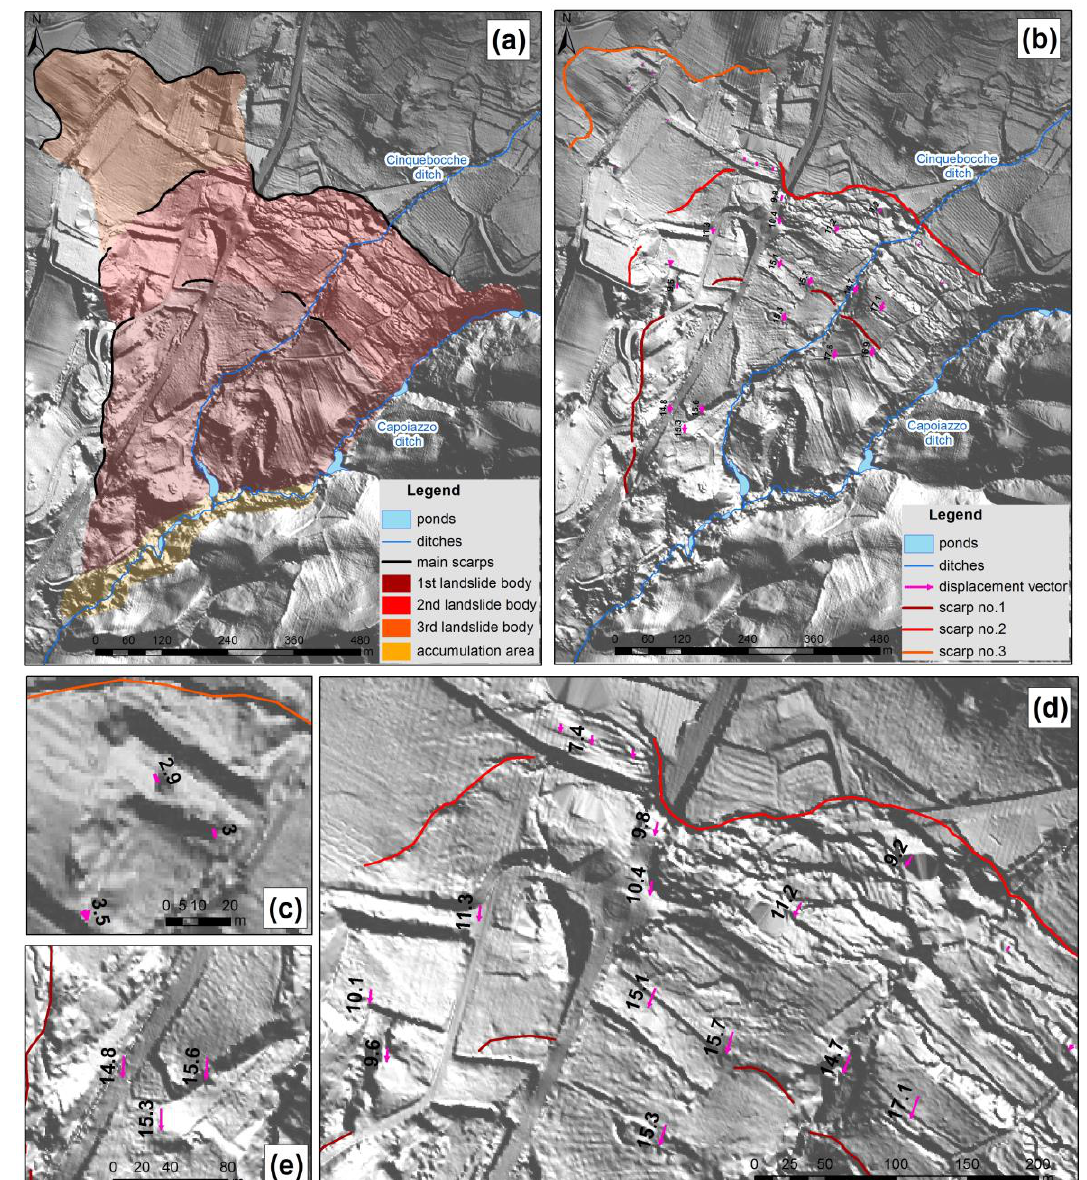
Figure 5. Dec2013DTM with indication of the sequence of the mobilization of the three landslide bodies and of the accumulation area ( a ), Dec2013DTM with horizontal displacement vectors and delineation of the three main scarps ( b ), detail of displacement vectors downslope the left-hand scarp no.3 of the landslide ( c ), detail of displacement vectors downslope the middle scarp no.2 ( d ), detail of displacement vectors downslope the scarp no.1 ( e ).